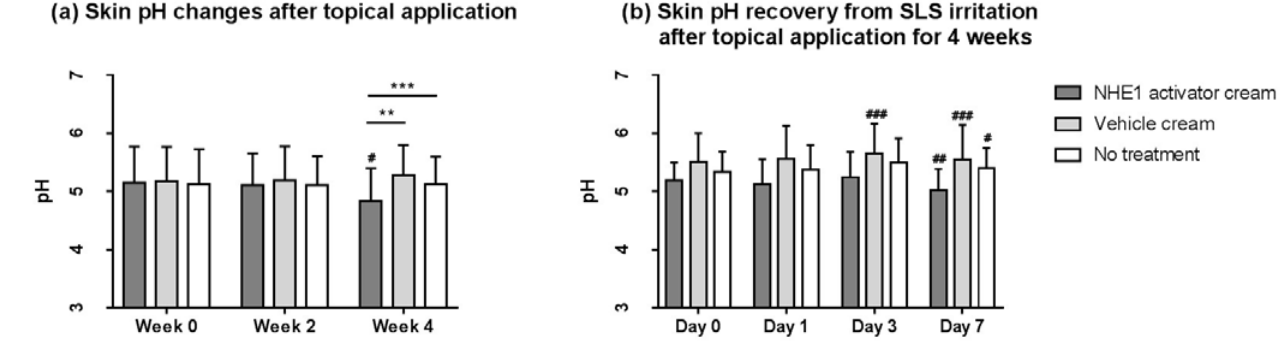
Figure 5. Skin pH changes after the NHE1 activator cream application. ( a ) Skin pH was measured after the application of the NHE1 activator cream ( M. officinalis leaf extract 0.05% and rosmarinic acid 0.1%) on the forearm, and application of the vehicle cream or no treatment on the other forearm. ( b ) After topical applications (NHE1 activator cream or vehicle cream) or no treatment for 4 weeks, skin pH recovery after sodium lauryl sulphate (SLS) irritation was assessed. Data are presented as the mean ± SD ( n = 21). Wilcoxon signed ‐ rank t ‐ test and Mann–Whitney U test p ‐ values indicate statistical significance (** p < 0.01, and *** p < 0.001; # p < 0.05, ## p < 0.01, and ### p < 0.001).